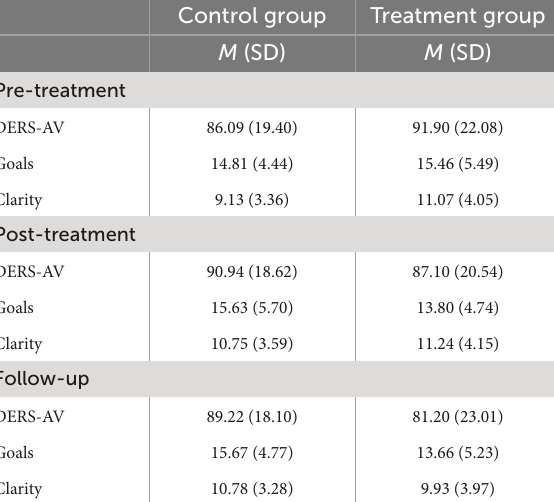
TABLE 2 Mean scores and standard deviations of the self-reported data for the treatment and control groups across the assessment